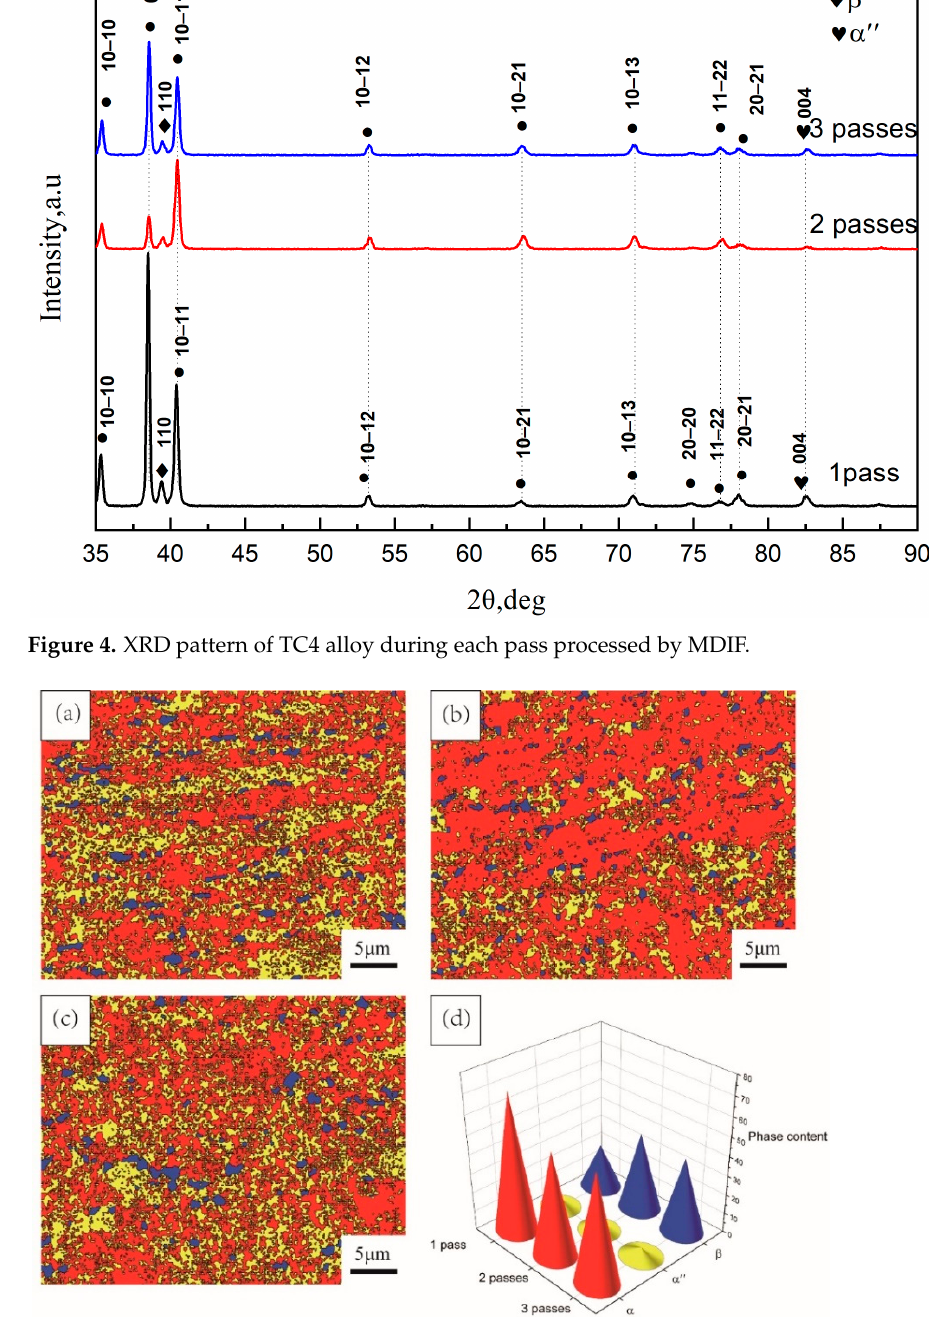
Figure 6. TEM image of TC4 alloy after one cycle of MDIF: ( a , b ) one pass; ( c ) two passes; ( d ) three passes. 3.2. Texture Evolution of Specimens after One Cycle of MDIF To obtain insight into the microstructural changes occurring, the (0001), (11 2(cid:3364) 0), and (1010) pole figure maps obtained from EBSD are presented in Figure 7, in which CD and TD represent the compression and transverse direction. The polar figure shows that the strongest texture was observed after the first pass of MDIF, and the high-density points